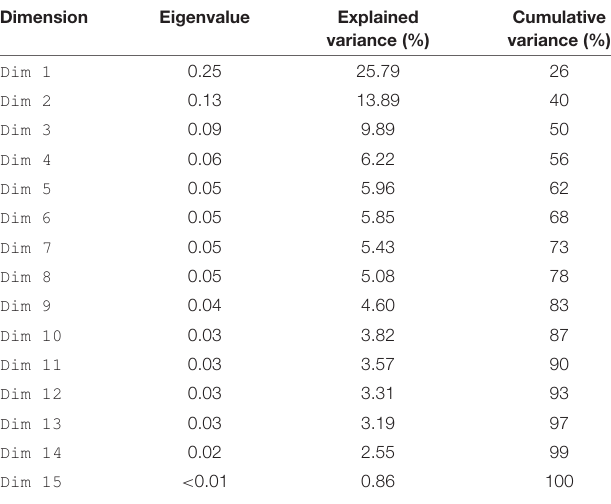
TABLE 2 | Eigenvalues and percentages of explained and cumulative